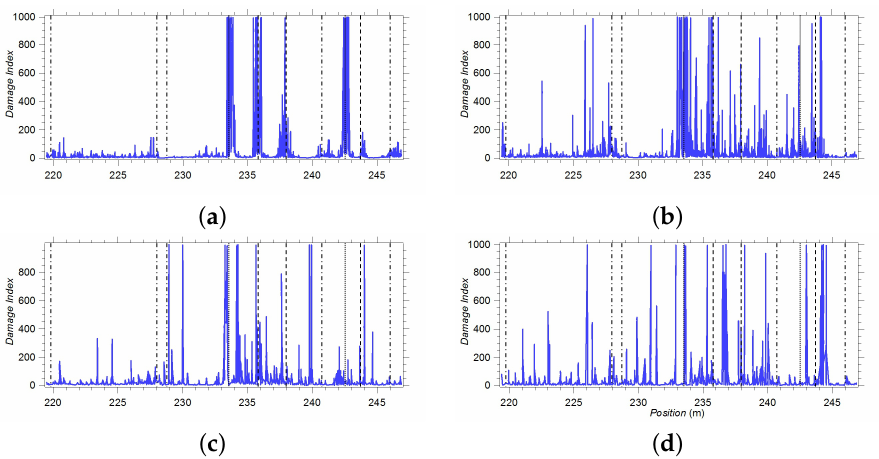
Figure 22. Example of damage index traces collected during tests (dashed lines = locations of defects; dashed-dotted lines = locations of welds; dotted lines = locations of joints). Testing speeds: ( a ) 1.6 km/h; ( b ) 8 km/h; ( c ) 16 km/h; ( d ) 24